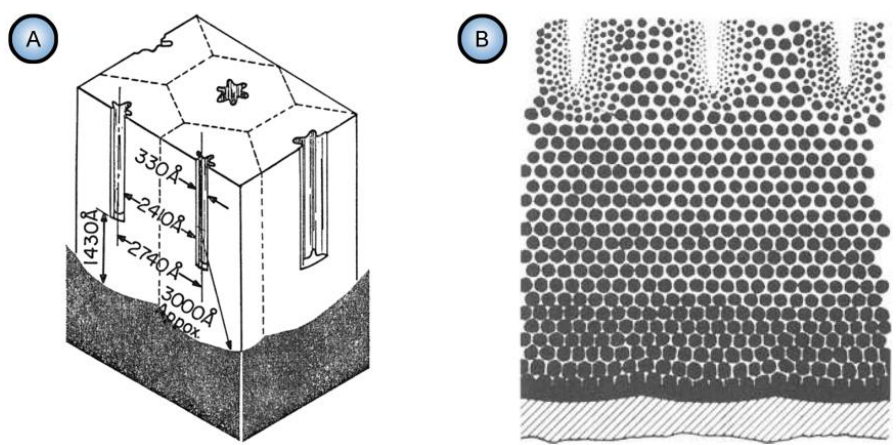
Figure 13. A comparison of two PAA structures assumed by the geometric model proposed by Keller et al. ( A ) and by the colloidal gel model proposed by Murphy and Michelson ( B ). In the colloidal gel model, electrolyte oxyanions adsorb to the surface of the particles and then facilitate the formation of a complex hydrogen-bonded water-containing system through which ionic conduction occurs. Reproduced from [111] with permission from The Electrochemical Society (1968).